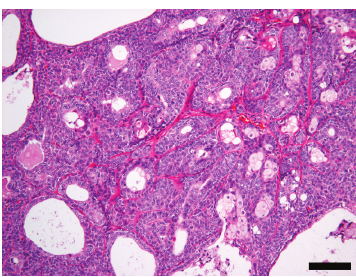
Figure 1: Histopathological appearance of the buccal mass. The mass is composed of the ductal structures lined by the bilayered luminal epithelial and basaloid tumor cells. Hematoxylin and eosin (HE). Bar = 100 𝜇 m.